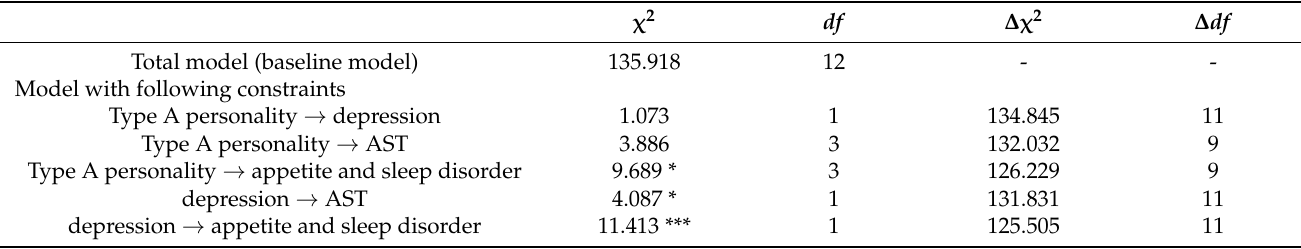
Table 3. Results of multiple-group model direct